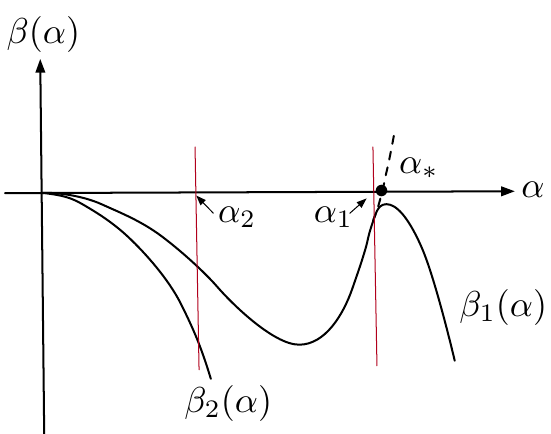
Figure 4 . The beta functions (cid:12) of the bi-fundamental Dirac fermions is broken at (cid:11) 1 for SU(2) 2